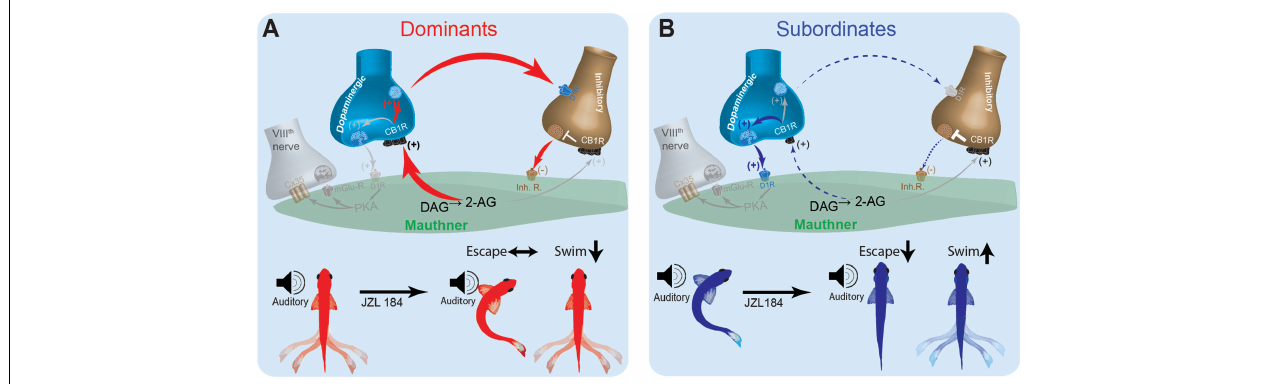
FIGURE 7 | Schematic model for social status-dependent regulation of neurochemical inputs to the M-cell: The M-cell (green) receives inputs from DA cells (blue), the excitatory VIIIth cranial nerve (gray), and inhibitory (brown). Our model predicts distinct neurochemical pathways in dominants (A) and subordinates (B) responsible for differences in startle escape sensitivity. These pathways are proposed based on differential effects of JZL184 treatment on startle escape behavior (bottom). Higher baseline 2-AG in dominants is responsible for activation of the “inhibitory pathway” via inhibitory neurotransmitter release. Lower baseline 2-AG in subordinates activates the lower threshold “excitatory pathway” via the VIIIth nerve, responsible for higher startle escape sensitivity.